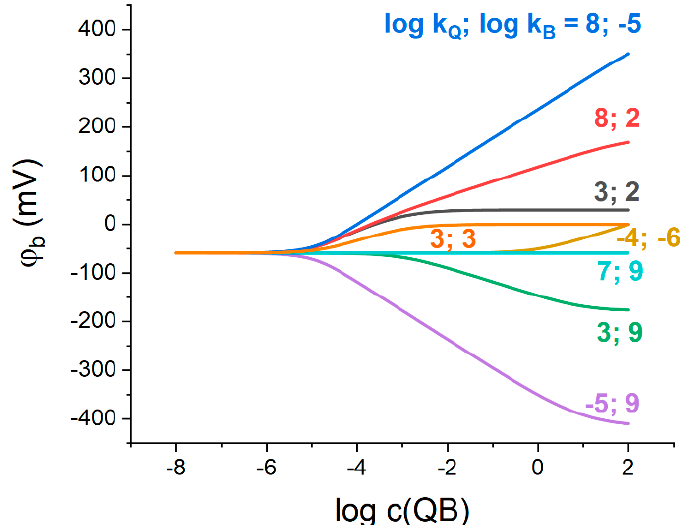
Figure 1. Phase boundary potential simulated at arbitrary Q + and B – ionic partition coefficients (indicated in the plot in log units) vs. Q + B − concentration in the membrane phase. c ( MX ) = 10 − 3 M. Here and below the concentrations of the membrane species refer to the entire volume of the polymeric phase.